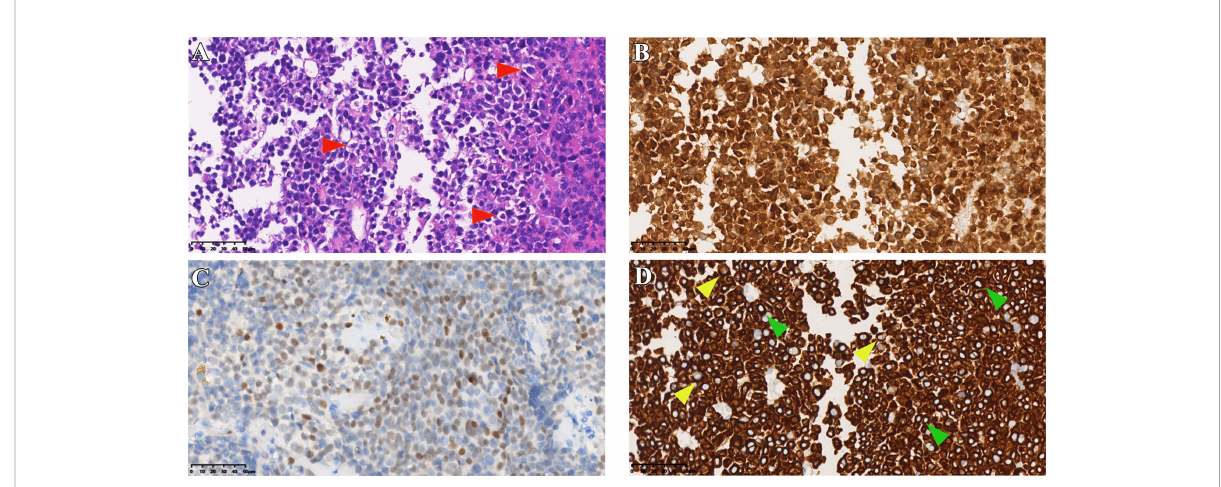
FIGURE 5 Immunostainingresultsof case 3. (A) HE stainingof tumortissue(redarrowsindicatetypical Crooke ’ shyaline change). (B,C) Immunohistochemical